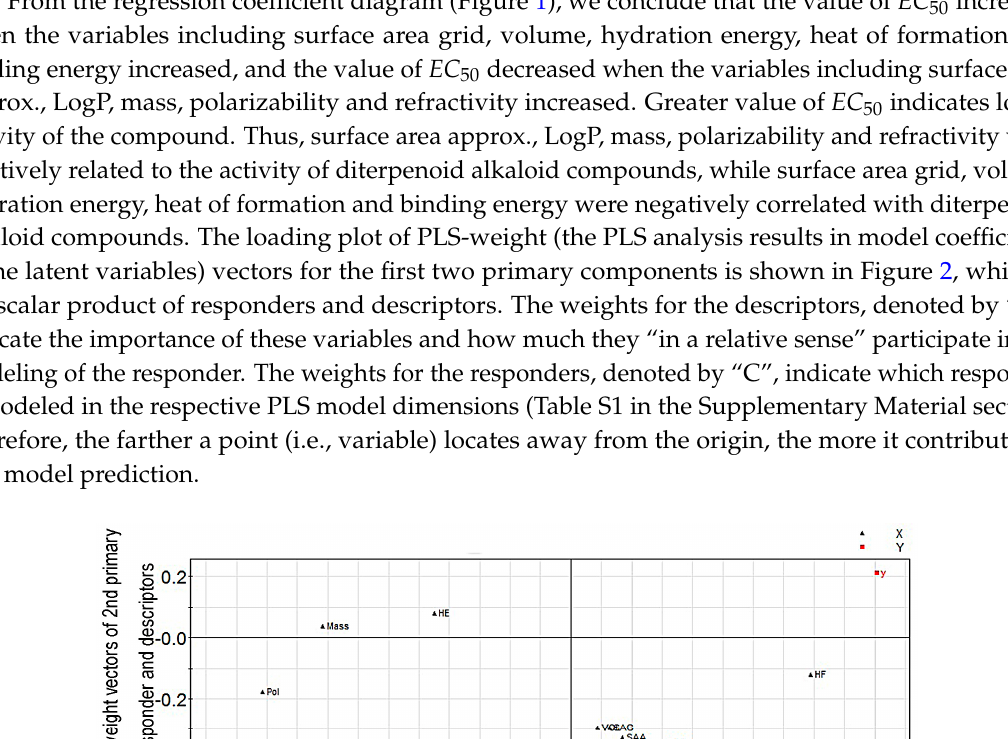
Figure 1. The regression coefficient diagram of descriptors in the QSAR model.